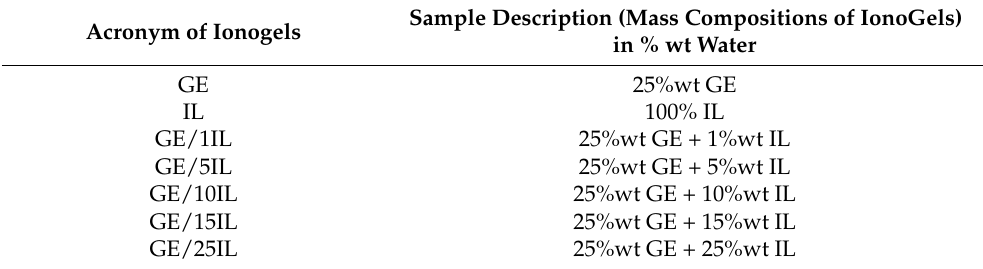
Table 2. The acronym designates the Ionogels formed from the gelatin at a fixed weight ratio dispersed in the emulsions of IL in water at the corresponding concentrations under study.